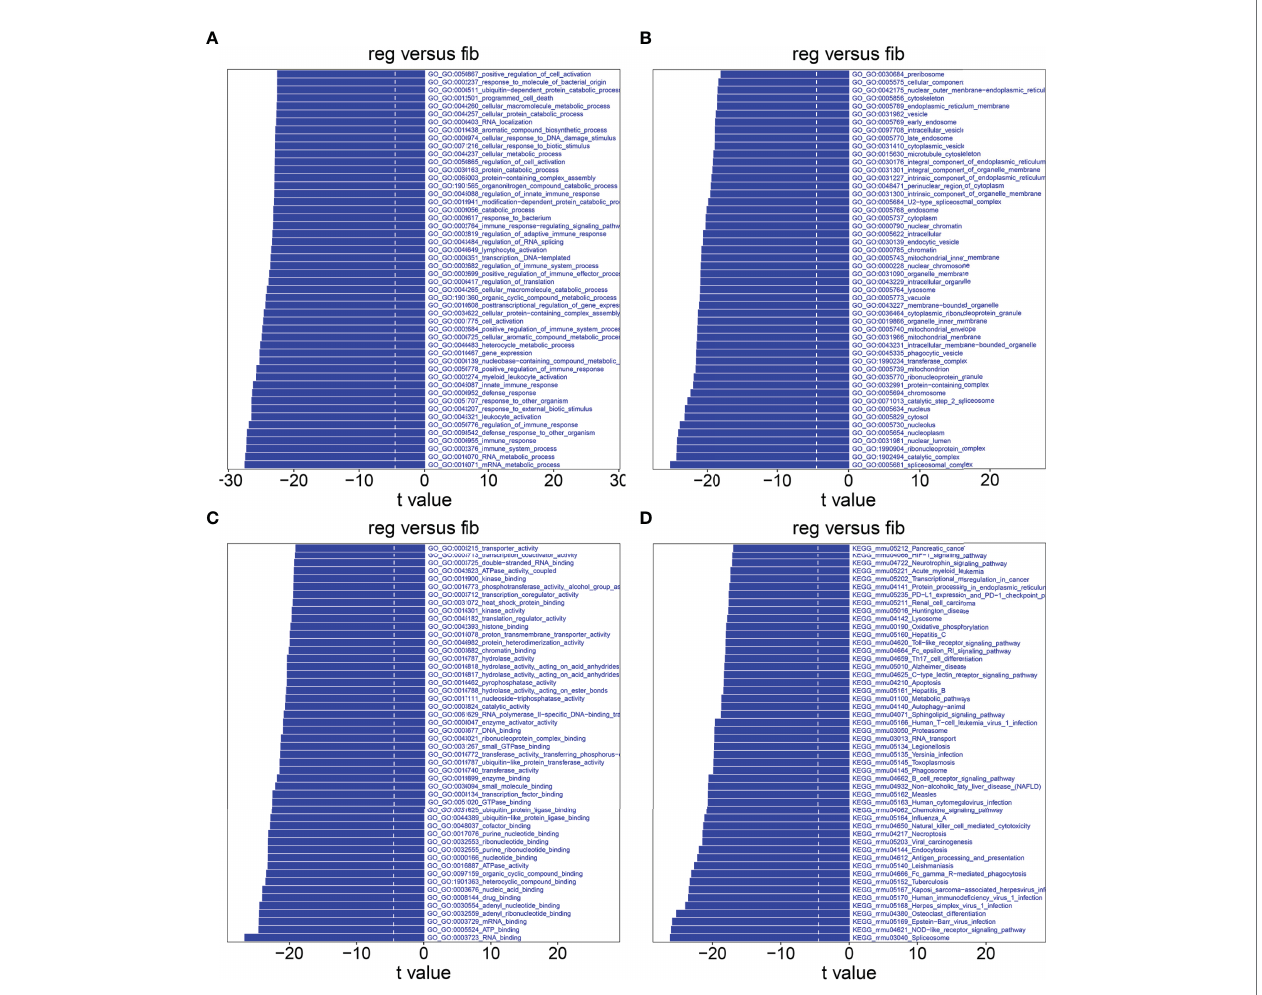
FIGURE 9 | GSVA between fi brotic and regenerative macrophages. (A – D) Heatmaps visualizing the differences in activation of biological processes, cellular components, molecular functions, and KEGG pathways between fi brotic ( fi b) and regenerative (reg)